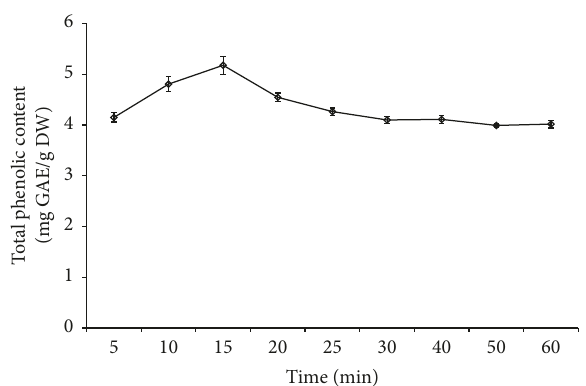
Figure 3: Effect of different duration of extraction on the extraction output of phenolic compounds from pear fruit samples.